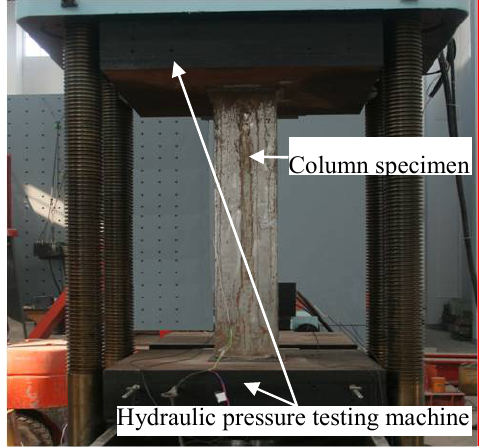
Figure 4. 5000 kN hydraulic pressure-testing machine.